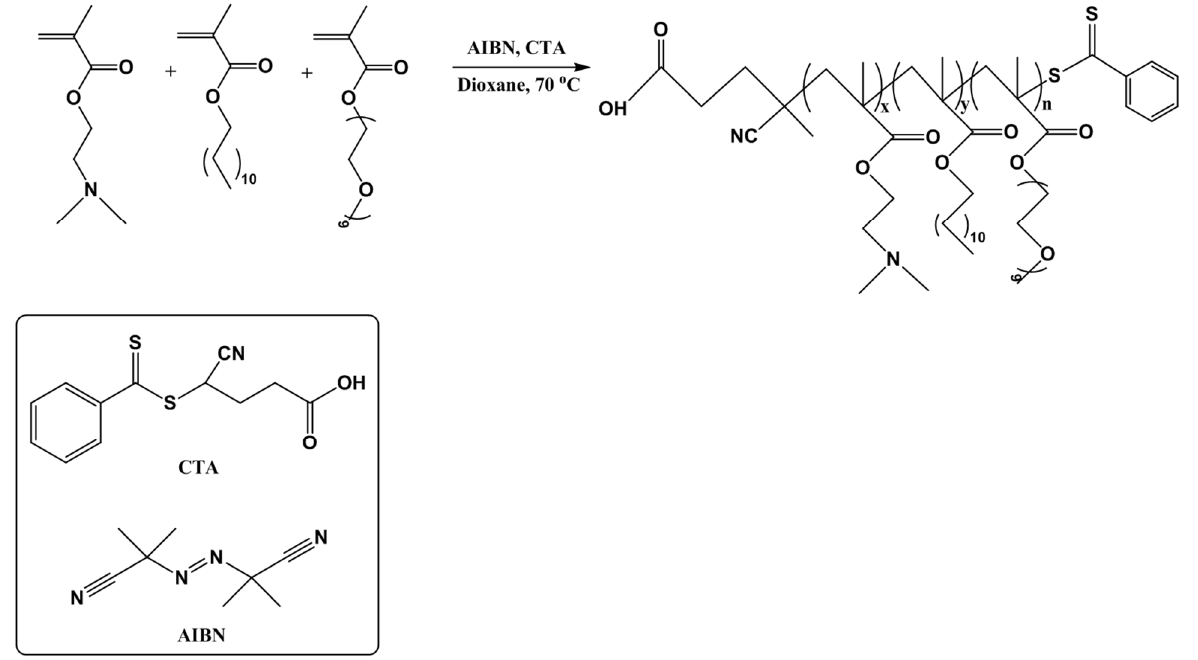
Table 1. Molecular characteristics of the five P(DMAEMA-co-LMA-co-OEGMA)